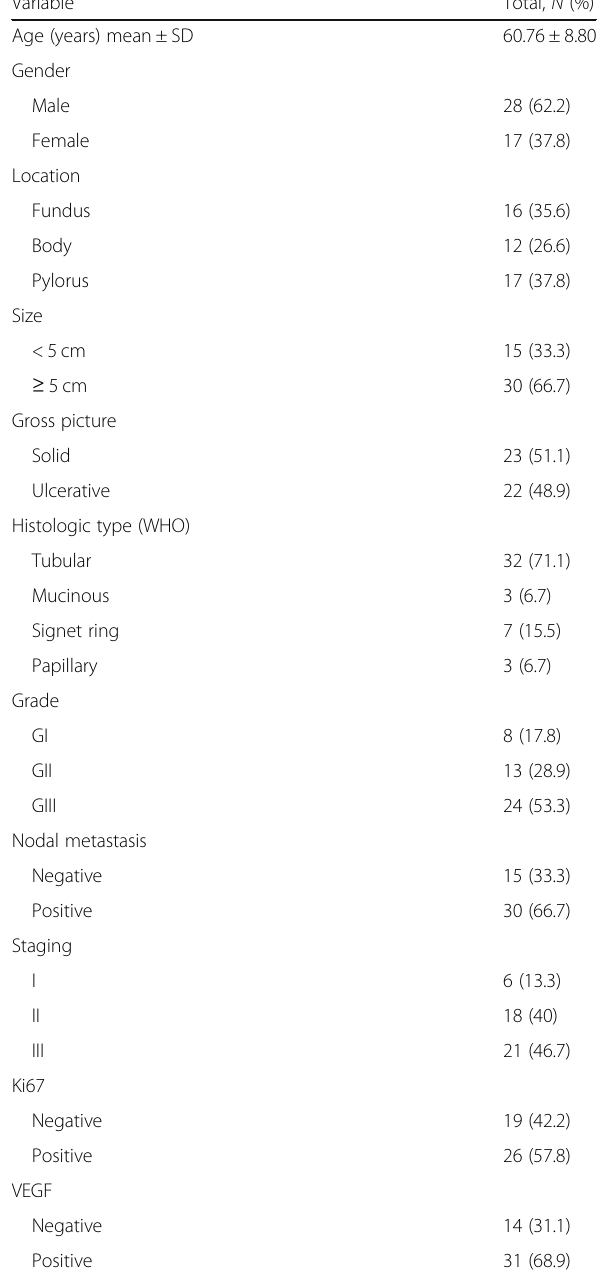
Table 1 Clinicopathological characteristics of studied